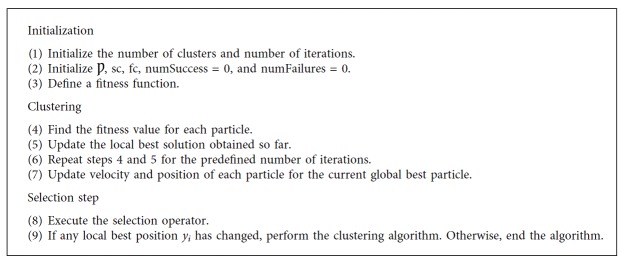
GCPSO algorithm [15].